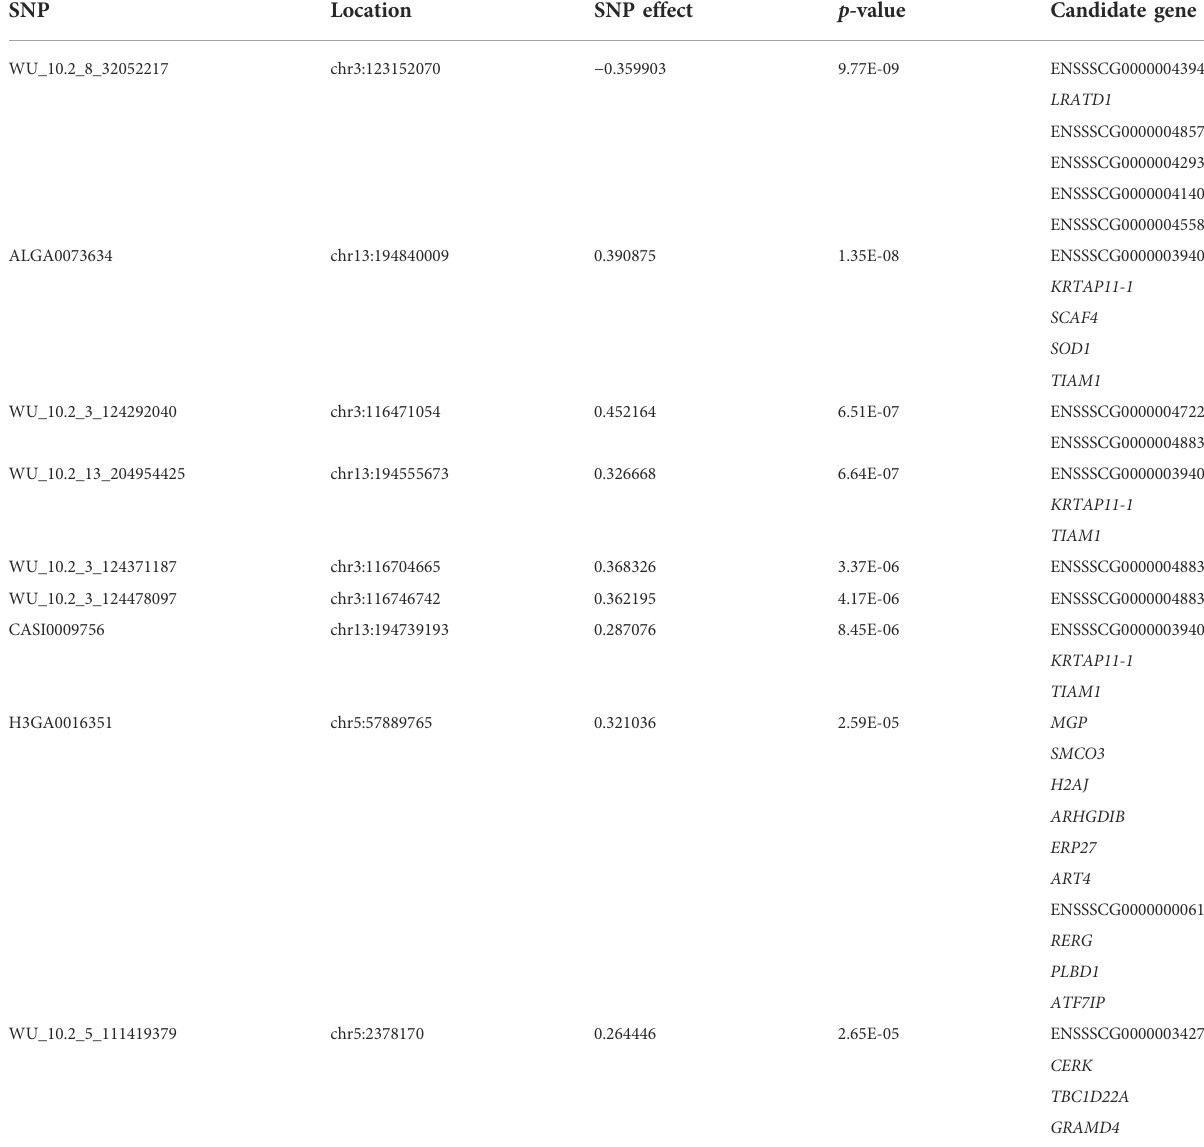
TABLE 1 The signi fi cant SNPs identi fi ed by GWAS analysis of GGP Porcine 50K Chip. SNP